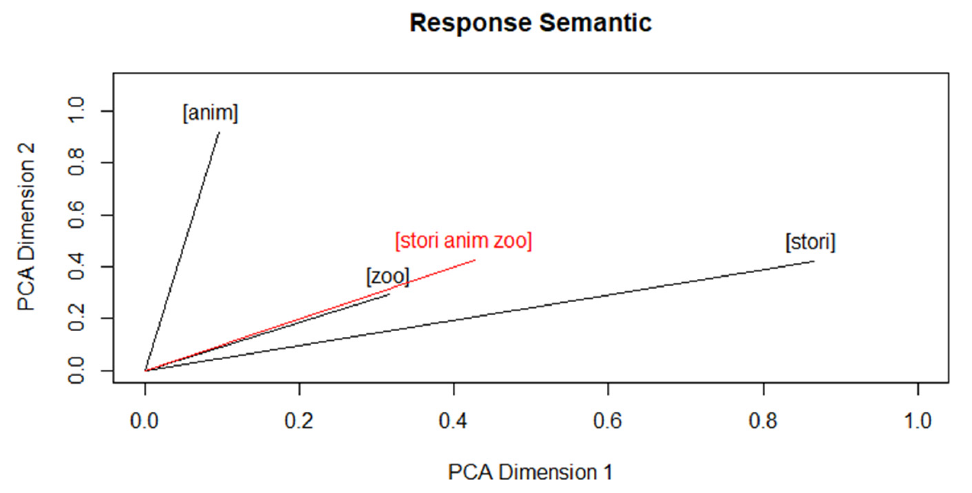
Figure 2. From word to response semantics. This plot reduces the hyperdimensional semantic space to two dimensions by Principal Component Analysis (PCA).